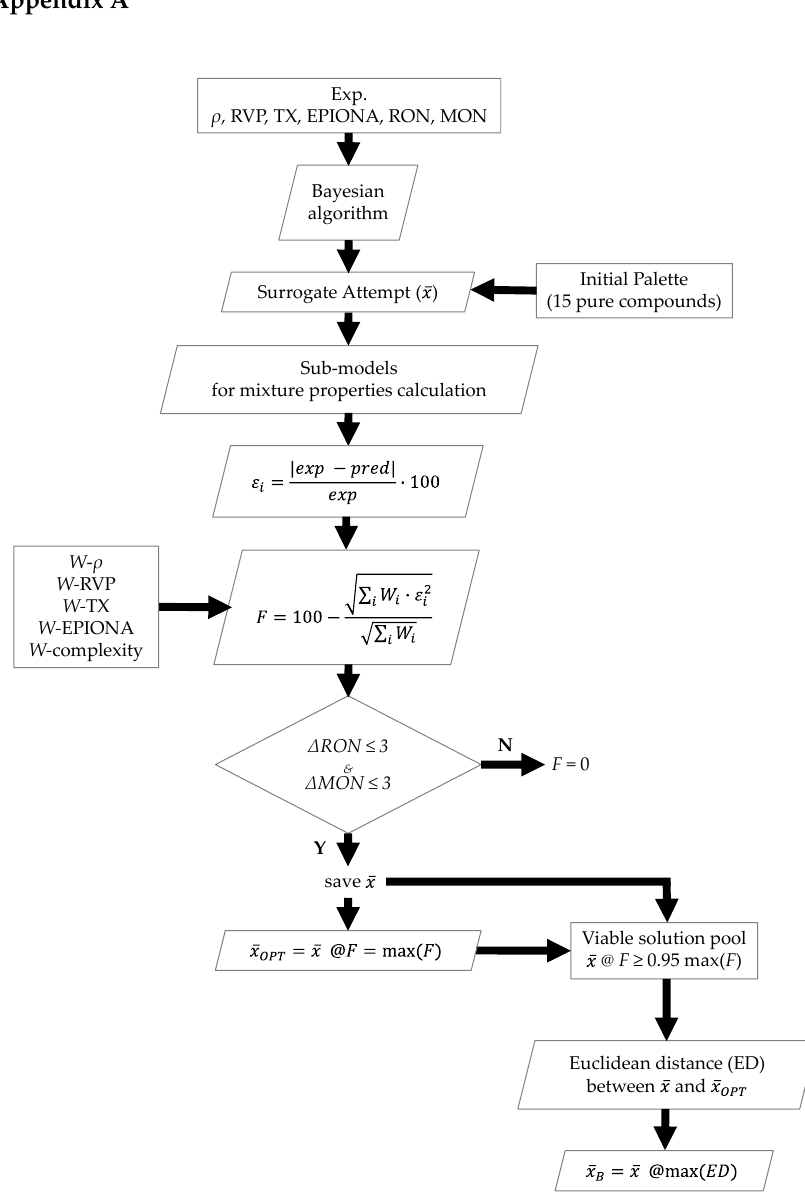
Figure A1. Main workflow of the implemented surrogate identification strategy. Table A1. Main available useful properties of the validation gasolines, collected from literature.